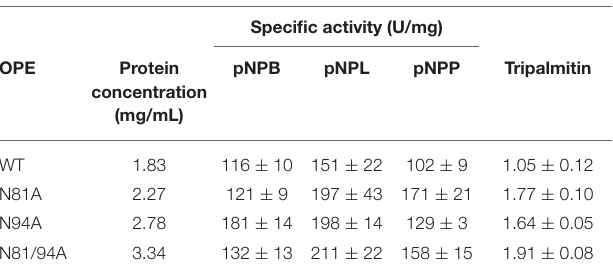
TABLE 1 | Activity against different p -nitrophenol esters of WT and mutant variants of OPE.